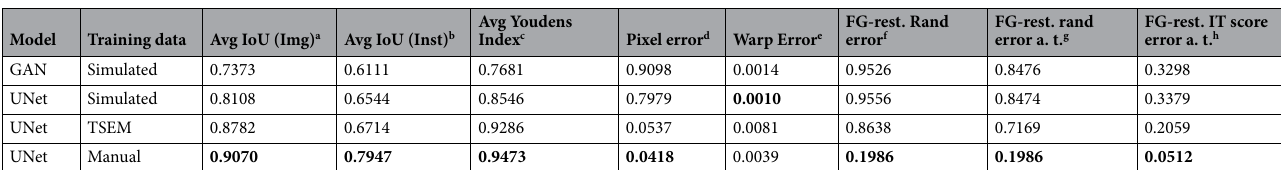
Table 1. Comparison of the models discussed in the text according to different metrics. a Average IoU score calculated for the entire image. Value between 0 and 1, higher is better. b Average IoU score calculated separately for each particle instance. Value between 0 and 1, higher is better. c Average Youden’s Index. Value between 0 and 1, higher is better. d Minimum pixel error. Value between 0 and 1, lower is better. e Minimum splits and mergers warping error. Value between 0 and 1, lower is better. f Minimum foreground-restricted Rand error. Value between 0 and 1, lower is better. g Minimum foreground-restricted Rand error after border thinning. Value between 0 and 1, lower is better. h Minimum foreground-restricted information theoretic score error after border thinning. Value between 0 and 1, lower is better.